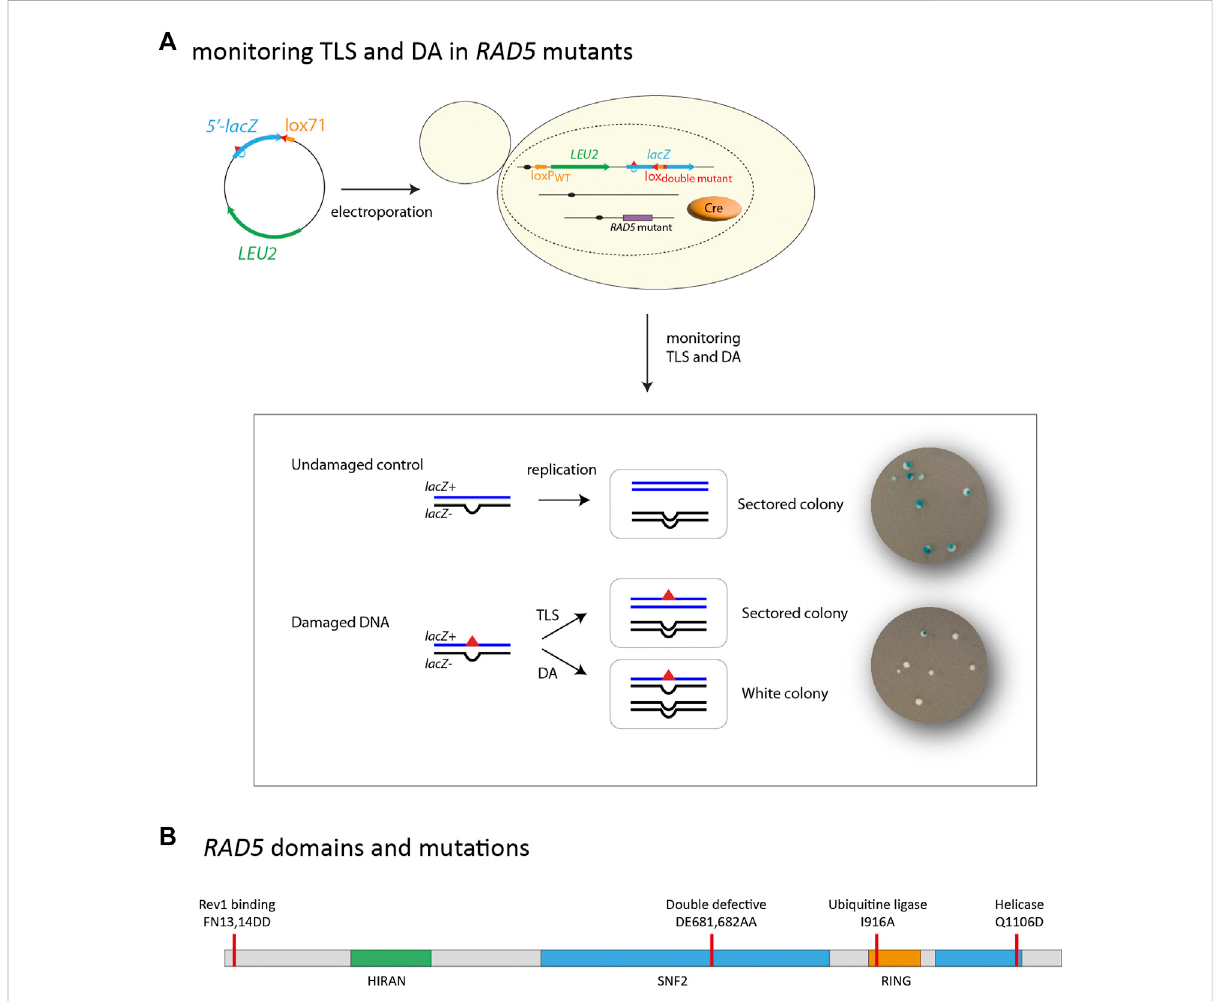
FIGURE 1 (A) outlineoftheintegrationsystem:Anon-replicativeplasmidcontainingasinglelesionisintegratedintooneoftheyeastchromosomesusing Cre/lox site-speci fi c recombination. The integrative vector carrying a selection marker (LEU2) and the 5 ′ -end of the lacZ reporter gene containing a single lesion is introduced into a speci fi c locus of the chromosome with the 3 ′ -end of lacZ . Chromosomal integration of undamaged lac-/lac + heteroduplex constructs leadtosectoredcoloniesonindicating media. Replicationofthedamagedheteroduplex yieldsalac+event whenthe lesion isbypassed byTLS, whereas complementary strandreplication yields alac — event. Damage Avoidance (DA)events leadto two lac-events and therefore to the formation of white colonies. Lesion tolerance rates are calculated as the relative integration ef fi ciencies of damaged vs. non- damagedvectors. (B) Schematic of RAD5 genehighlighting thehelicasedomain aswellastheRINGubiquitinE3domain.Mutationsuseditthisstudy are indicated. Mutation FN13,14DD affects the Rev1 binding site. Mutation DE681,682AA inactivates both the helicase and ubiquitin ligase activity. Mutation I916A inactivates the ubiquitin ligase activity. Mutation Q1106D inactivates the helicase